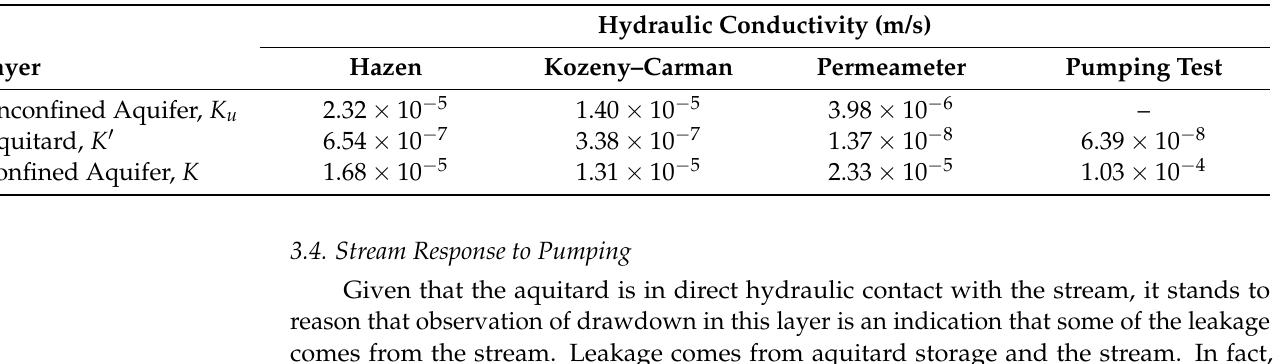
Table 4. Comparison of laboratory-measured values K to estimates from pumping test data. Hazen and Kozeny–Carman values are based on laboratory particle size